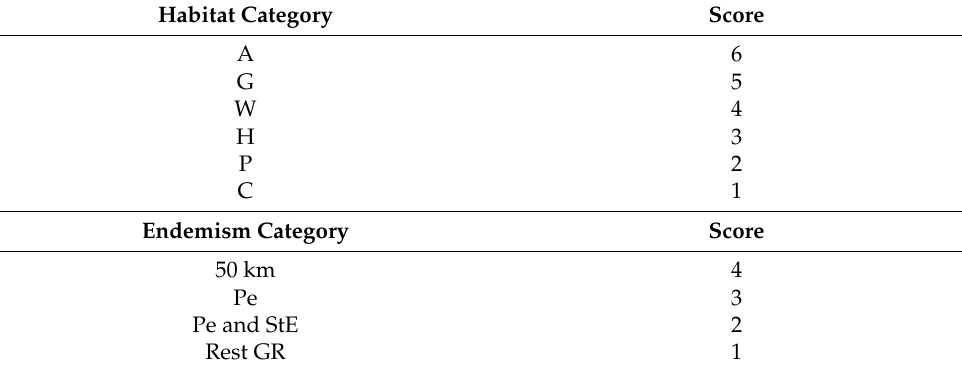
Table 5. Score assigned to habitat and endemism categories. Abbreviations for habitat categories as in Table 4, endemism categories as in Table 2. Coastal, as well as ruderal and agricultural habitat categories (listed as M and R in Table 4), have been omitted since the former category does not occur in Mts. Oligirtos and Famrakas, and the latter does not host any Greek endemic species in the same